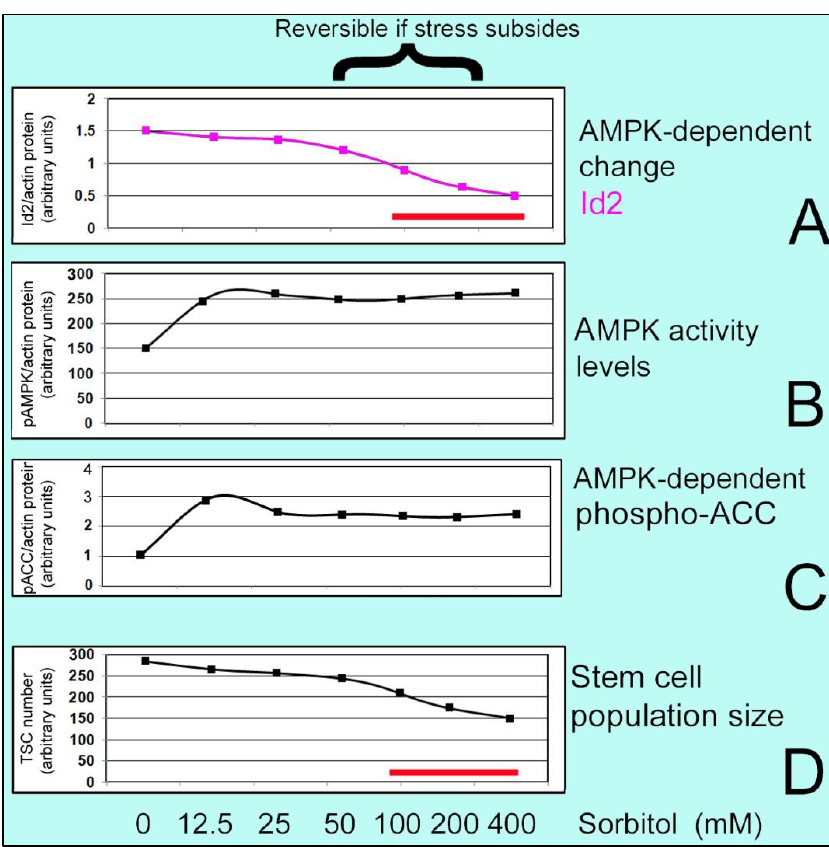
Figure 3. S-shaped curve for low dose stem cell survival and high dose organismal survival through compensatory differentiation. At low concentrations of Sorbitol, stem cell population size (D) and Inhibitor of differentiation (ID2) level (A) are not significantly changed but AMPK-dependent phosphorylation of ACC and inactivation of its anabolic activity do occur at low doses (C). At higher doses the accumulation rate decreases (D) and AMPK-dependent (B) decrease in Inhibitor of differentiation (ID2) protein level leads to induction of differentiation. Standard error of the mean was between 1% (cid:177) 8% of the mean. Red bars in (A) and (D) show range of stress-induced